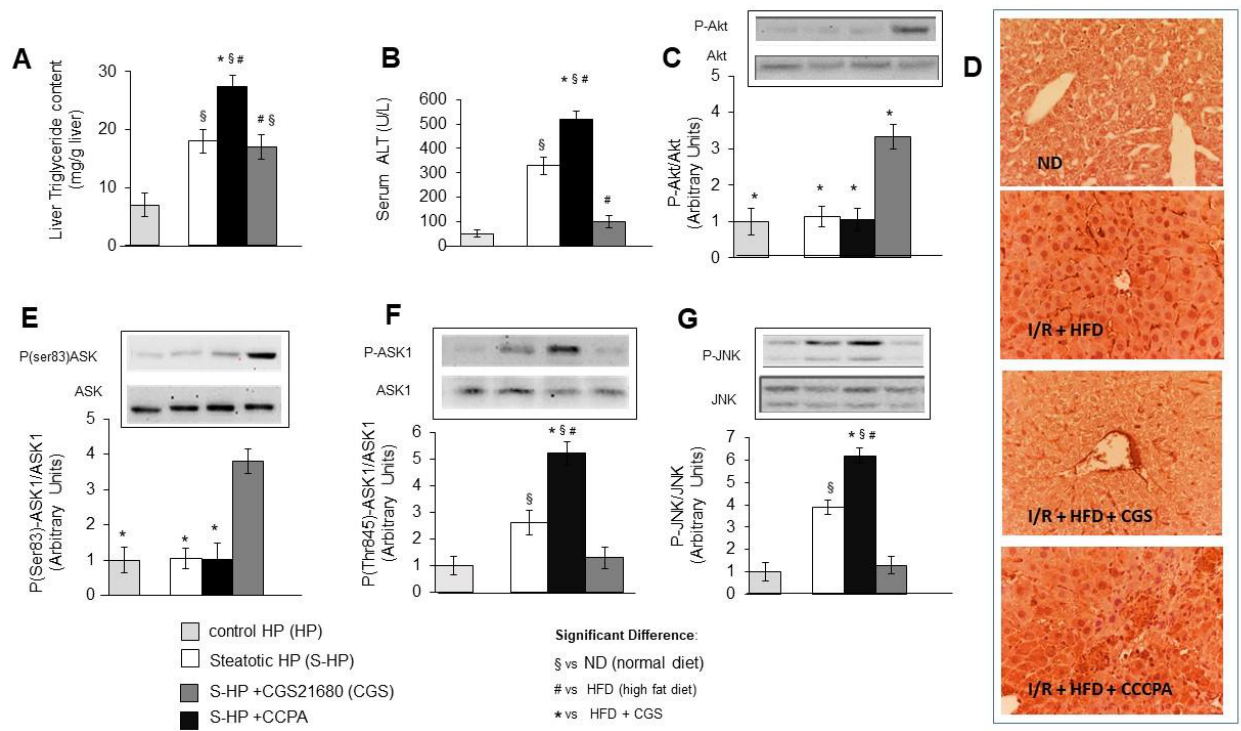
Figure 4. Effects of pharmacological A2AR and A1R stimulation on hepatic IRI of steatotic mice. Mice fed with normal (ND) or high fat diet (HFD) for 9 weeks, treated or not by I.P. injection with the A2aR agonist, CGS21680 (0.5 mg/kg) or with the A1R agonist CCPA (1.5 mg/kg), were subjected to 45 min of ischemia followed by 120 min of reperfusion (IR). ( A ) Hepatic triglyceride content ( B ) ALT release ( C ) Akt activation ( D ) Visualization of activated ASK1 ( E ) ASK1 inhibition; ( F ) ASK1 activation; ( G ) JNK activation. The results represent the mean of 3 experiments ± SD. Statistical significance: * # § p < 0.05.